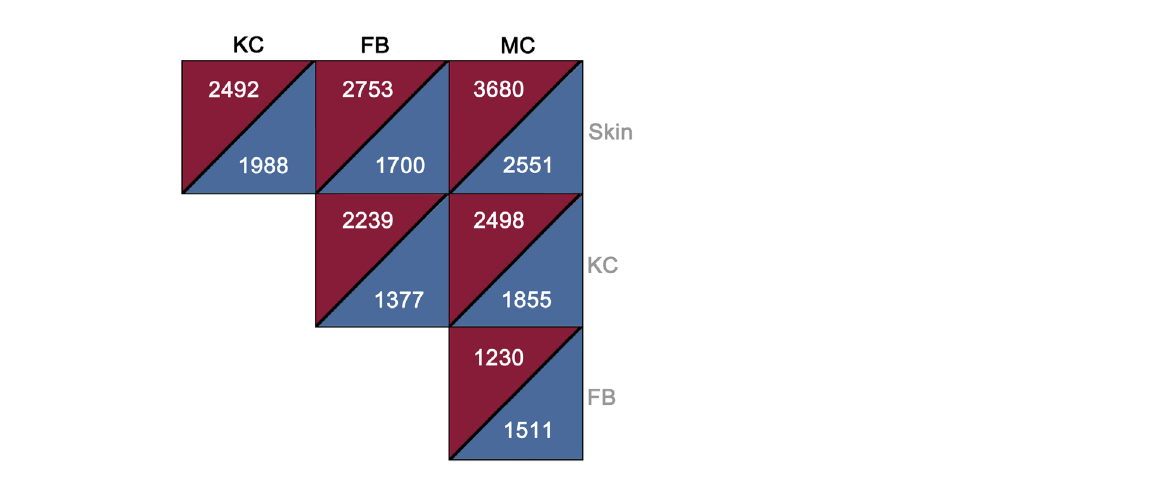
Fig. 1. The number of differentially expressed genes in each study group - melanocyte (MC), keratinocyte (KC), fibroblast (FB) and whole skin (Skin). Red triangles – upregulated genes, blue triangles – downregulated